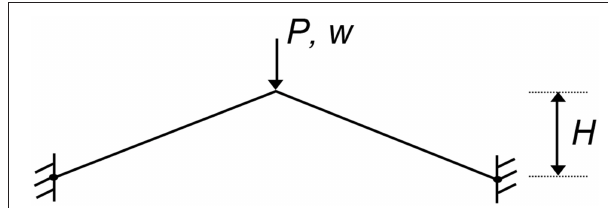
FIGURE 5 | Schematic diagram of a toggle frame under transverse load P causing the frame to snap through with displacement w . The height H of the toggle frame is a free parameter that can be varied in a numerical continuation solver to investigate the system’s snapping